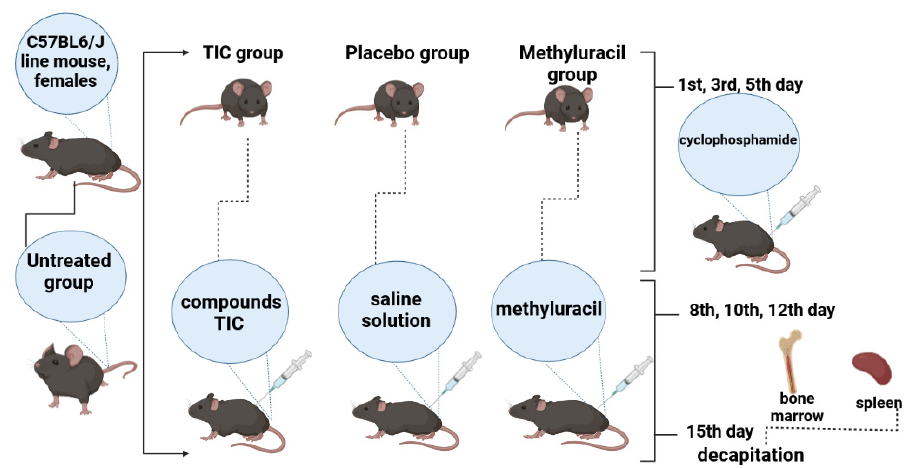
Figure 5. Experiment design.